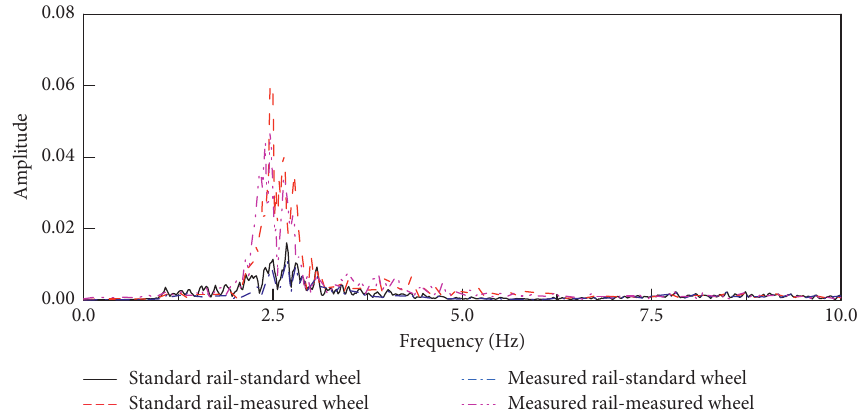
Figure 15: Comparison of the main frequency of vehicle body transverse vibration acceleration.